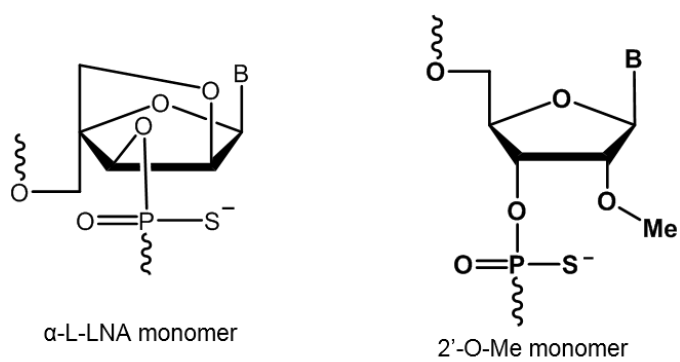
Figure 1. Structural representation of the phosphorothioate nucleic acid analogues used in this